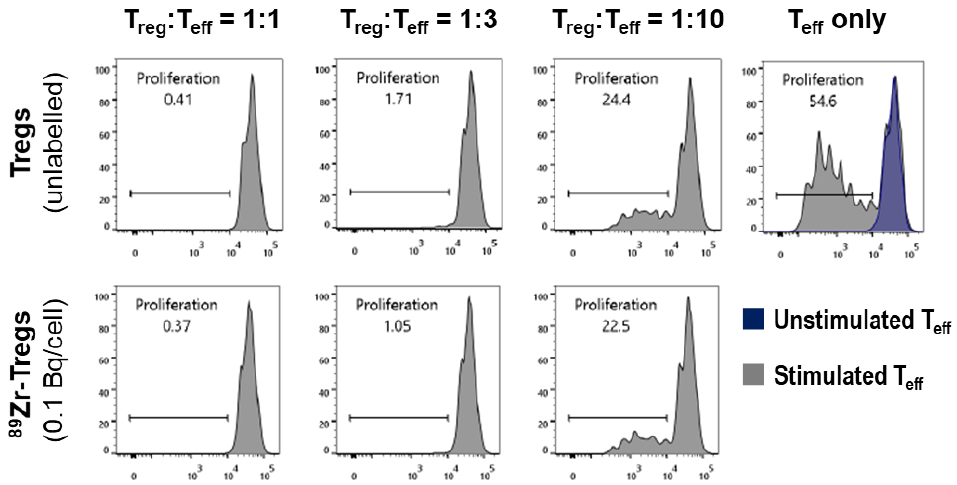
Figure 4. Suppressive capacity of radiolabelled 89 Zr-Tregs. Dye-labelled effector T cells (Teffs) were allowed to proliferate in the absence (top right panel—gray: CD3/CD28-stimulated; purple: unstimulated) or presence of Tregs (all other panels). Teff proliferation was assessed from the reduction in intracellular fluorescent dye concentration, which reduced with every cell division and was quantified by flow cytometry. ( top ) Unlabelled Tregs and ( bottom ) 89 Zr-Treg suppressed Teff proliferation in a dose-dependent manner. For this functional assay, 89 Zr-Tregs were radiolabelled at 0.1 Bq/cell. Assay duration was 5 days. A typical example of n = 3 is shown.